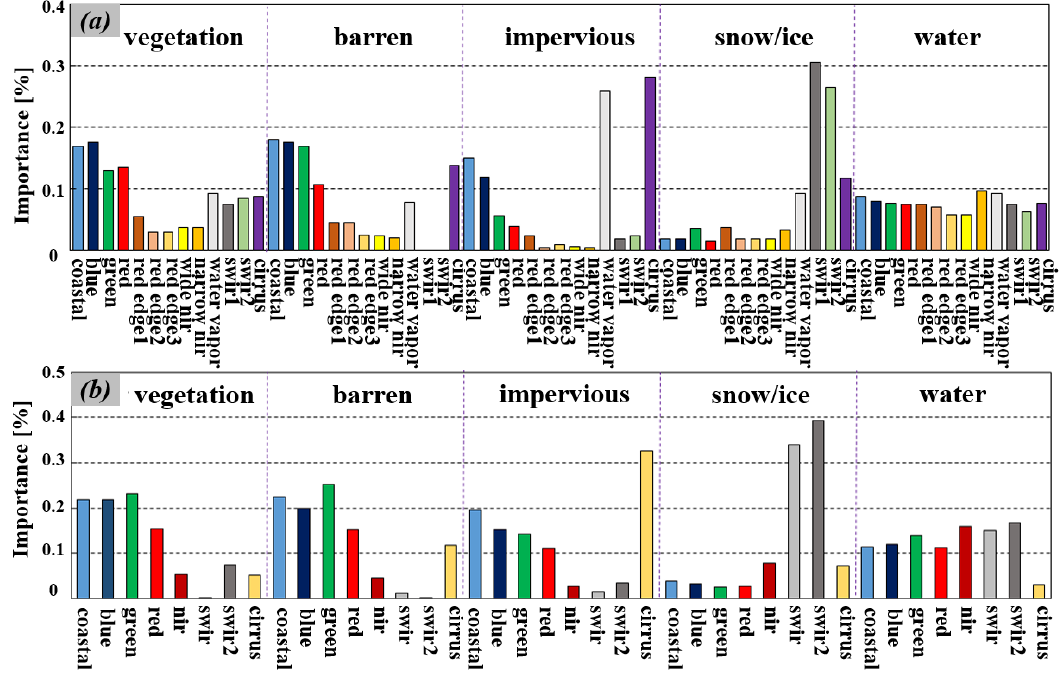
Figure 11. T he importance of the training bands of Landsat-8 and Sentinel-2 images for different environments, as found using the RF model. ( a , b ) show the importance of the different input bands of Sentinel-2 and Landsat-8 imagery,